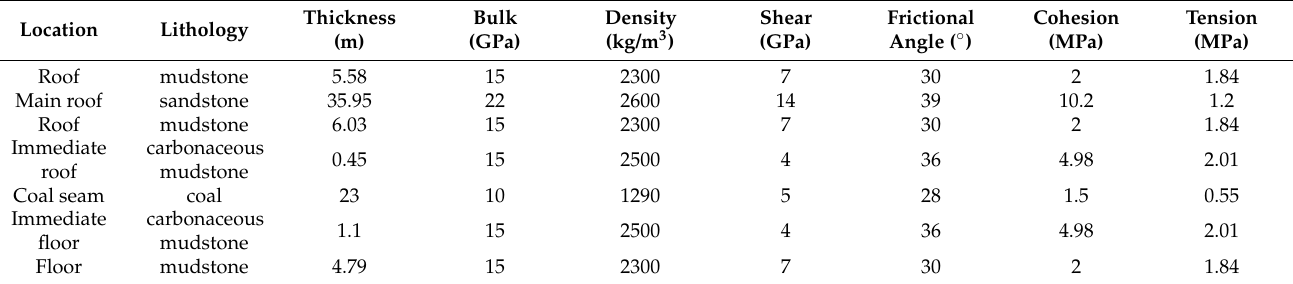
Figure 4. Numerical simulation model. Table 1. Characteristics of the mechanical parameters of the coal rock mass.